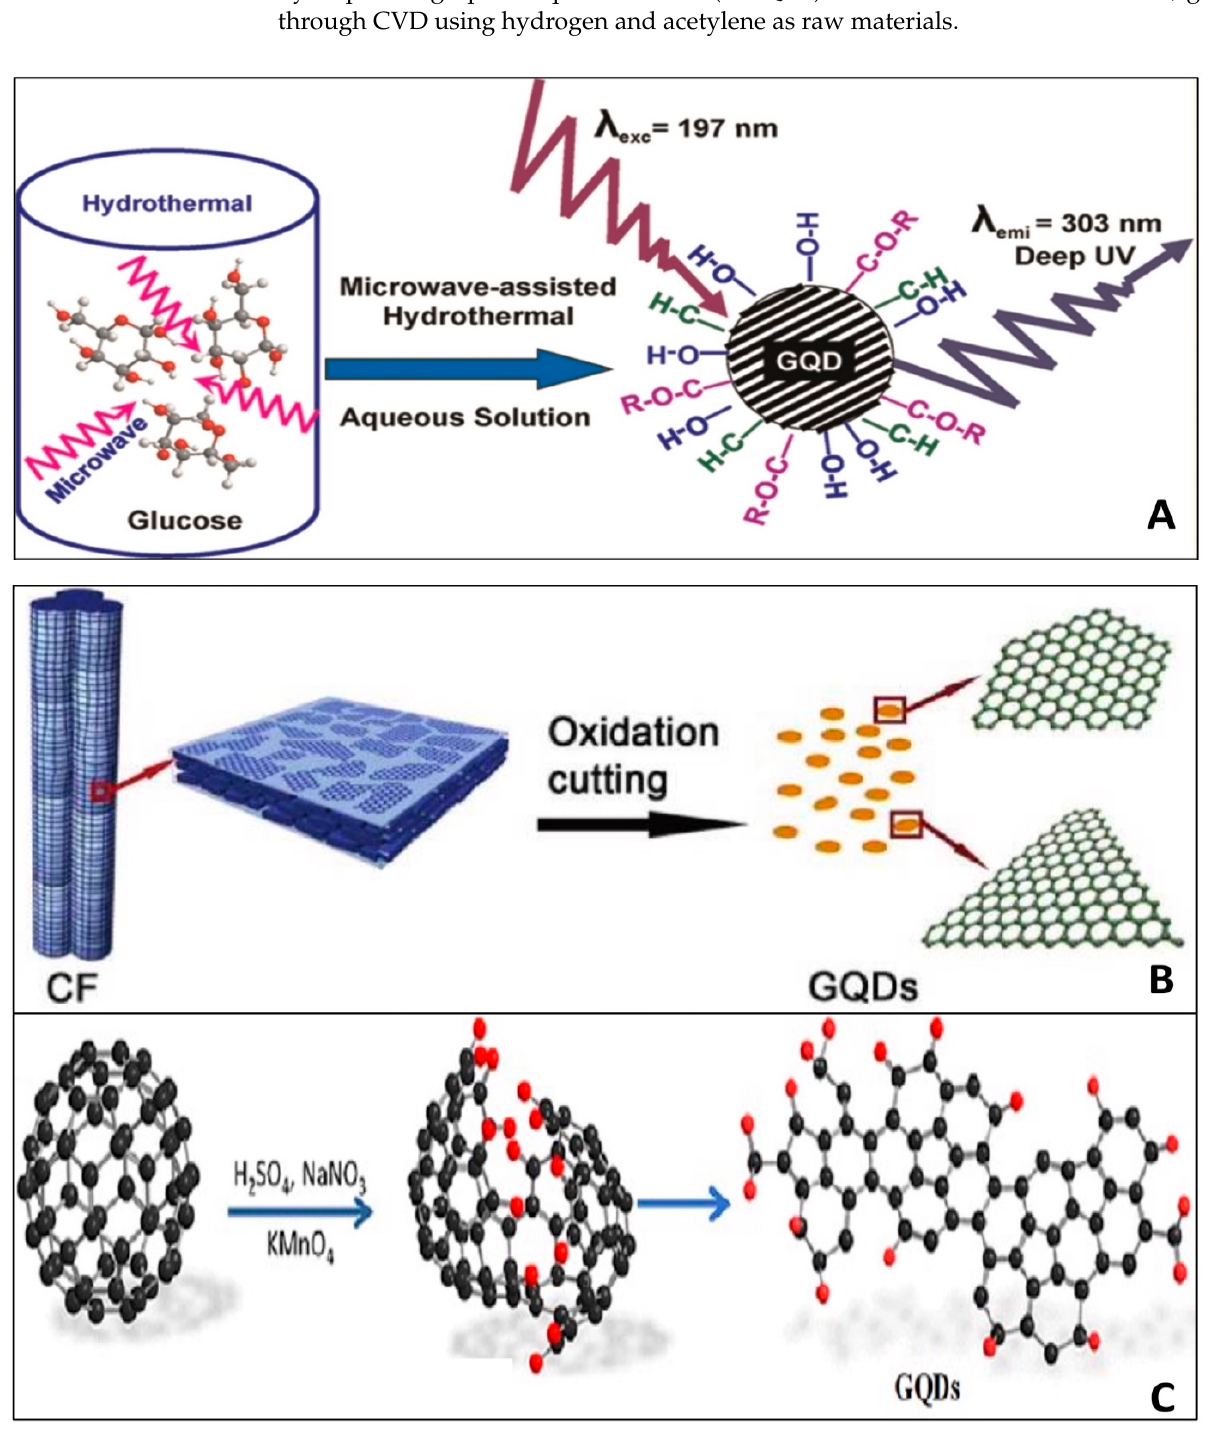
Figure 5. Synthetic approach for GQDs: ( A ) microwave assisted hydrothermal method (Adapted from the Ref. [130] with the permission of ACS); ( B ) oxidation cutting (Adapted from the Ref. [115] with the permission of ACS); ( C ) hydrothermal method (Adapted from the Ref. [117] with the permission of ACS).